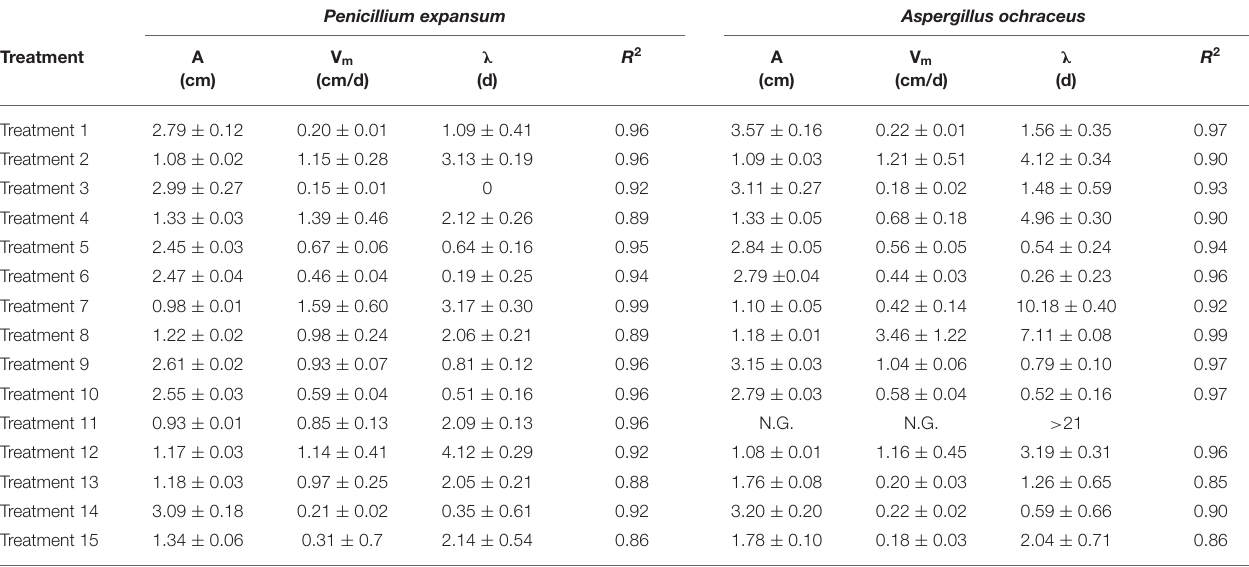
TABLE 5 | Parameters of the modified Gompertz equation for radial growth of Penicillium expansum and Aspergillus ochraceus , using Poliomintha longiflora Gray essential oil in combination with pH and protein